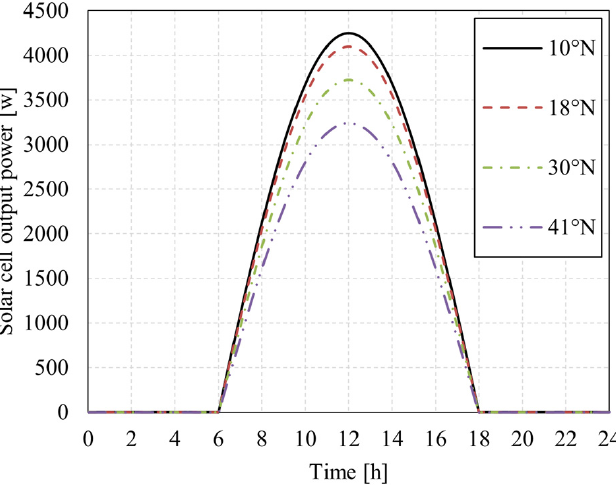
Figure 31. Comparison of PV cell output power at different latitudes (Apr. 21).